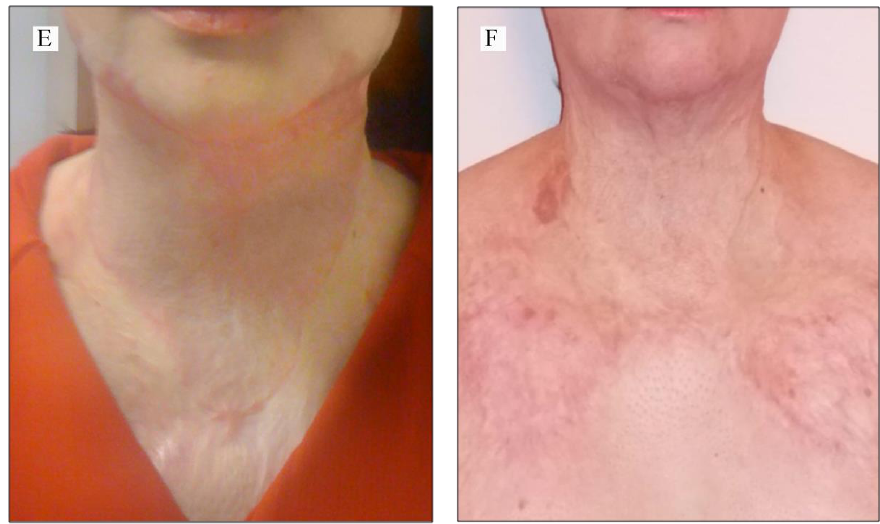
Figure 1. Case 1. A twenty-six years old female patient with 58% burned surface, flame burn (face, neck, anterior and posterior thorax, upper limbs, both axillae, lower limbs): ( A ) Aspect of the burn neck scar after two years-contractures, keloids and hypertrophic scars affecting the burned areas as well as the grafted parts; ( B ) image of the neck, after excision of the scars and contracted tissue; ( C ) final aspect of the neck seven days after application of epidermal autograft, frontal view; ( D ) final aspect of the neck seven days after application of epidermal autograft, frontal view; ( E ) Final aspect of the neck nine months after surgery. ( F ) Result at 11 years after surgery with soft, pliable skin more alike to normal skin.